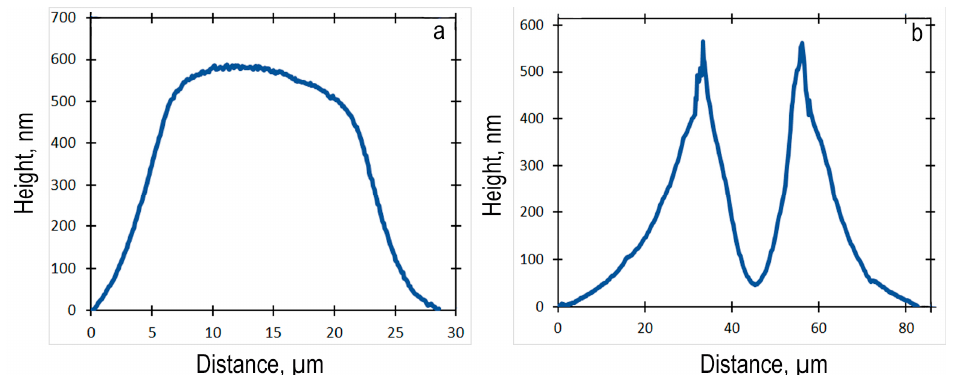
Figure 5. The AFM obtained cross-sections of ( a ) a drop printed on PDMS substrates cured for 3 min at 80 ◦ C and ( b ) a line printed on PDMS precured for 5 min at 80 ◦ C. Semi-contact mode was used for the AFM measurement.